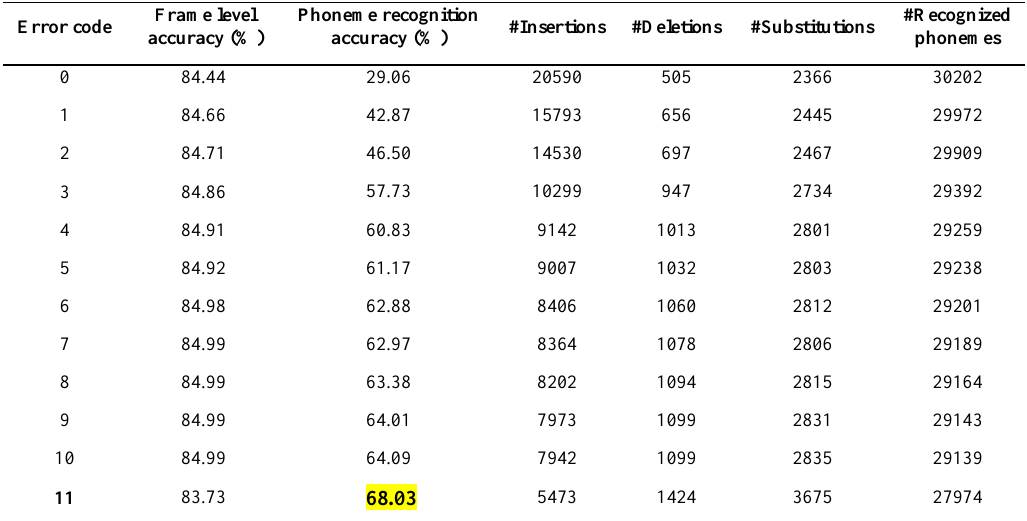
Table 2. Results of applying each step of post-processing method to generate phoneme sequence.